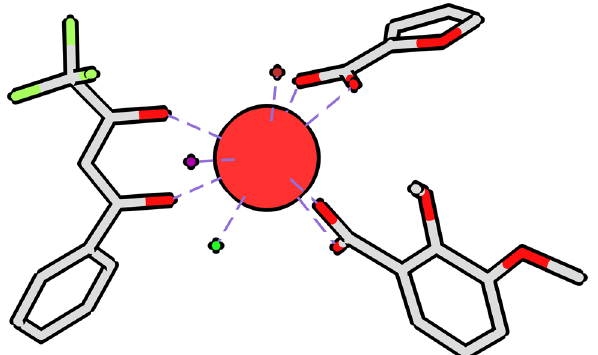
Figure 8. Example of a possible trivalent europium complex of generic formula Mabc(AB)(CD)(EF) 16 of coordination number nine with 66,816 conceivable coordination stereoisomers. Coordinate bonds are represented as dotted